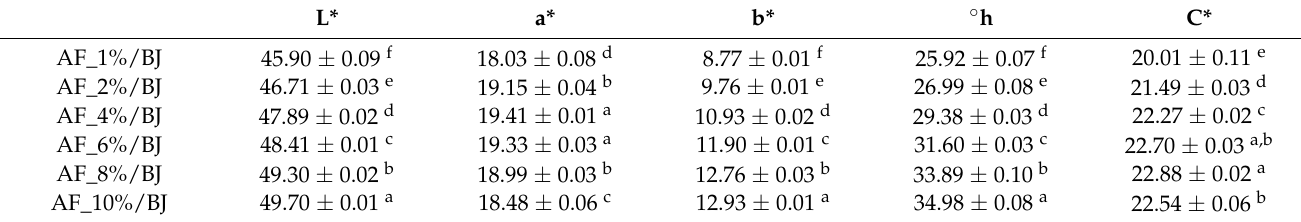
Table 5. Color parameters of apple fiber/blackberry juice